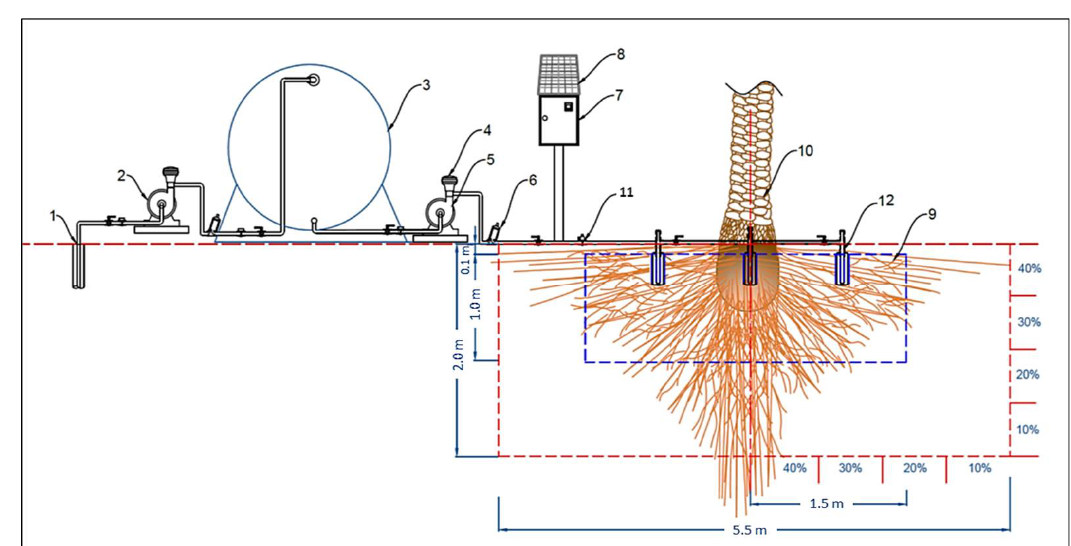
Figure 1. Schematic diagram of the essential components of the designed subsurface irrigation system (SIS). (1) Groundwater well, (2) Water pump, (3) Water tank, (4) Automatic water pump regulator, (5) Water pump, (6) Disc filters, (7) Control unit, (8) Solar panel, (9) Target root zone, (10) Date palm trunk, (11) Solenoid valve, (12) Subsurface irrigation unit.